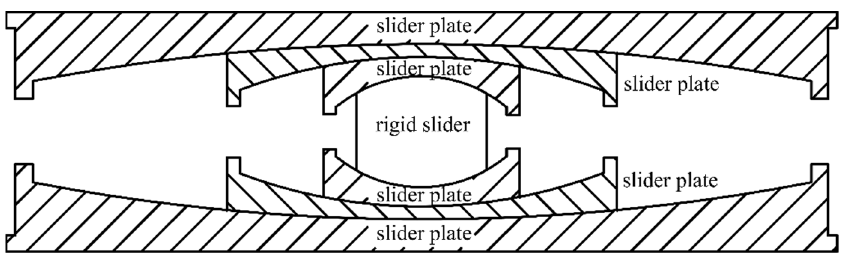
Figure 6. Schematics of a quintuple pendulum friction bearing.